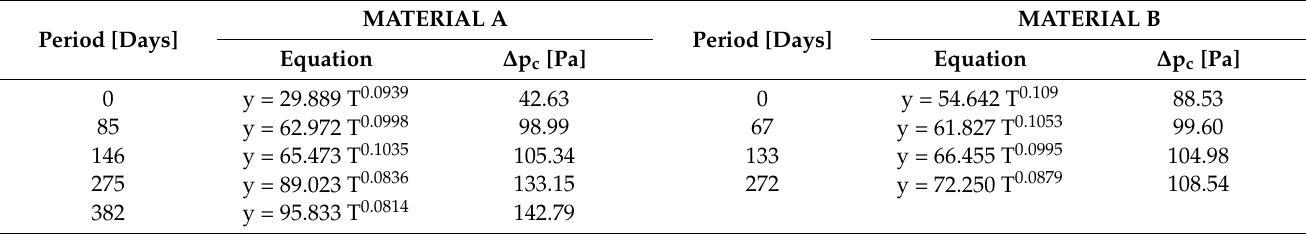
Table 5. Summary of regression equations and resistance values for the 50th filter cycle. Period [Days]